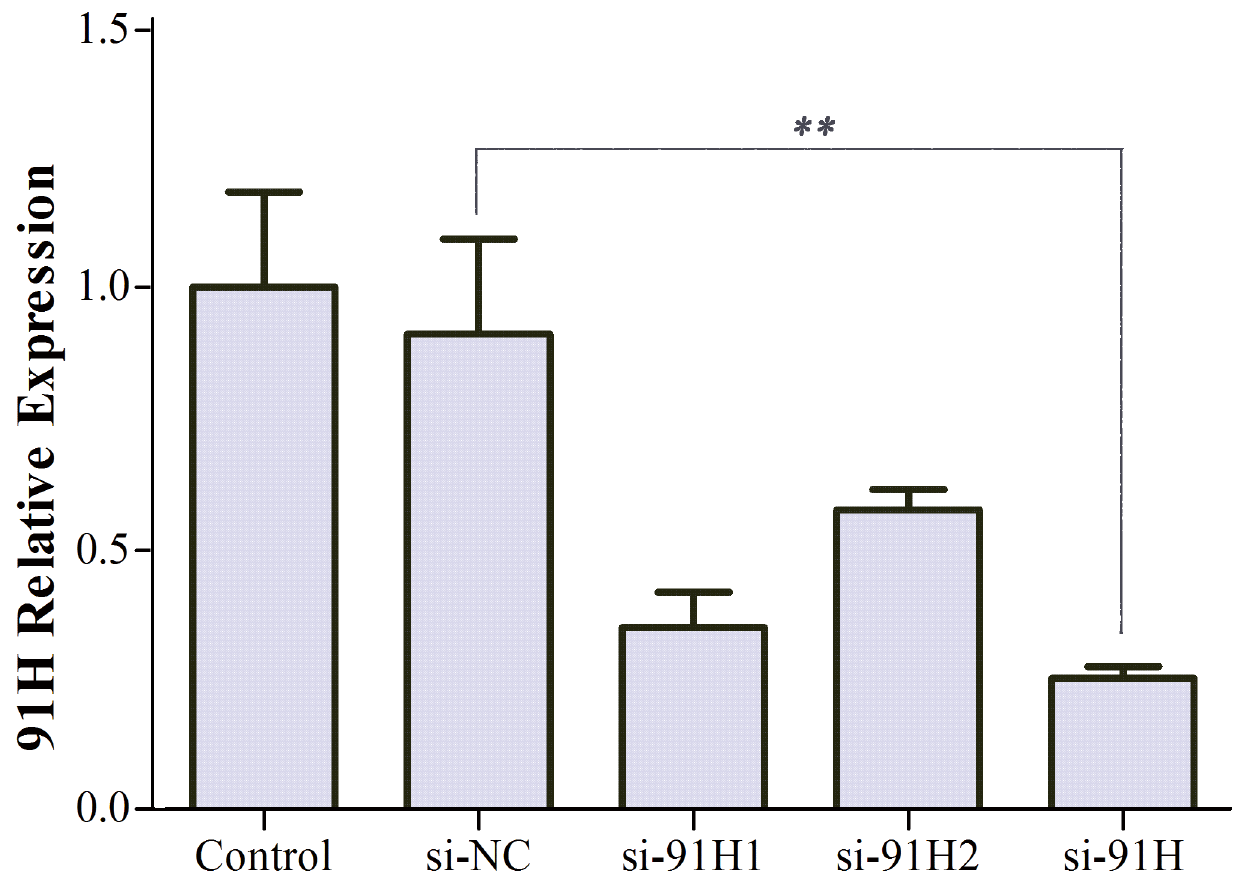
Figure 8. HCT-116 cells were transfected with si-NC and si-91H. After 48 h, 91H expression was effectively inhibited by qRT-PCR compared with si-NC (mean ± SEM; ** P , 0.01).